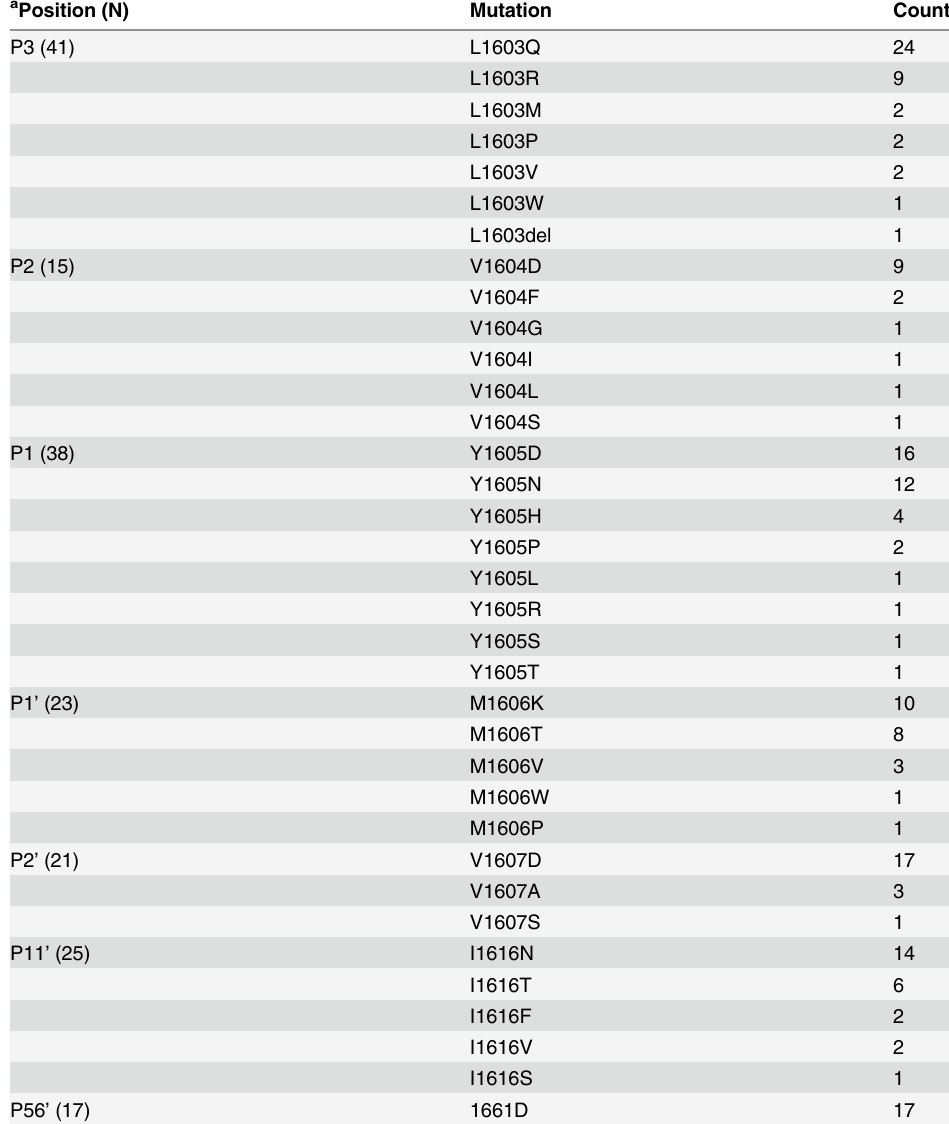
Table 2. Distribution of mutations in phage selected for resistance to